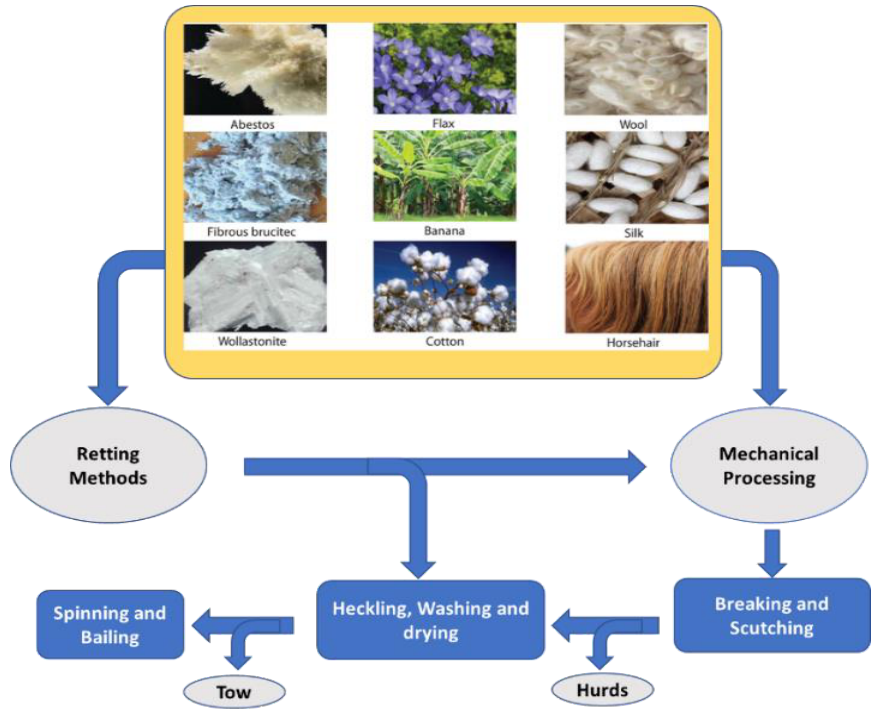
Figure 2. Extraction of bast fibers from source materials.